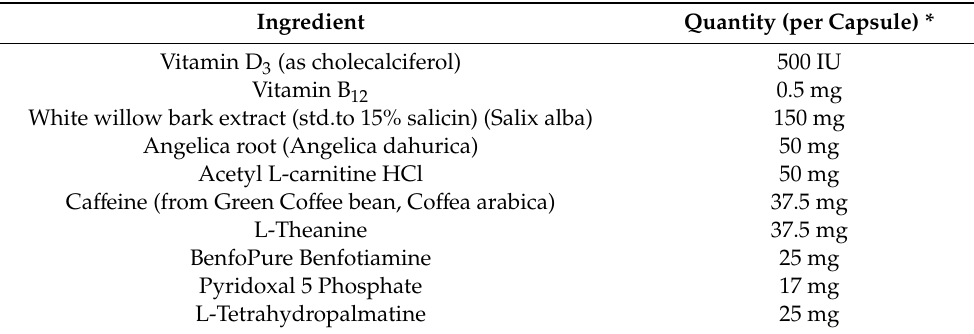
Table 1. Composition of Pain